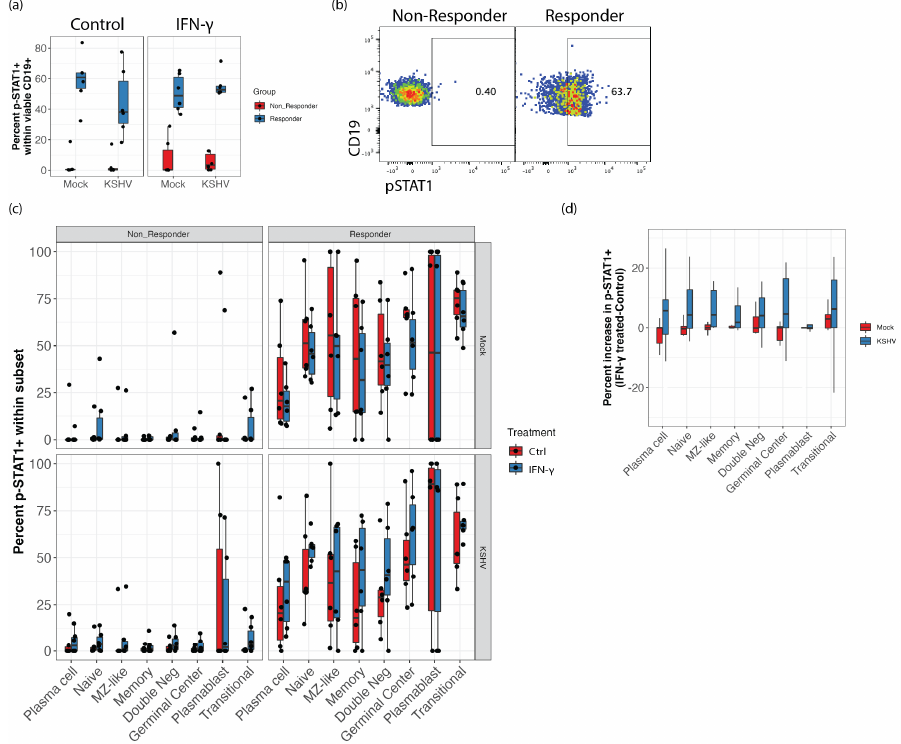
Figure 4. IFN- γ responsive samples have higher baseline pSTAT1. Phospho-flow cytometry for STAT1 Y701 ( a ) total pSTAT1 in responder (blue) vs. non-responder (red) groups under different culture conditions. Unpaired Wilcoxon test p = 0.002 comparing responder to non-responder groups for all conditions shown ( b ) representative flow cytometry plots showing pSTAT1 staining in untreated Mock samples for a responder and non-responder sample ( c ) pSTAT1 in B cell subsets in different culture conditions (facets) with (blue) or without (red) IFN- γ treatment. Unpaired Wilcoxon test comparing responder and non-responder groups were statistically significant ( p > 0.01, effect size > 0.6) for all comparisons except plasmablasts ( d ) Increase in pSTAT1 with IFN- γ treatment (treated-control) for B cell subsets comparing mock and KSHV-infected cultures (color) in responder group samples only. Comparisons in ( d ) are not statistically significant.